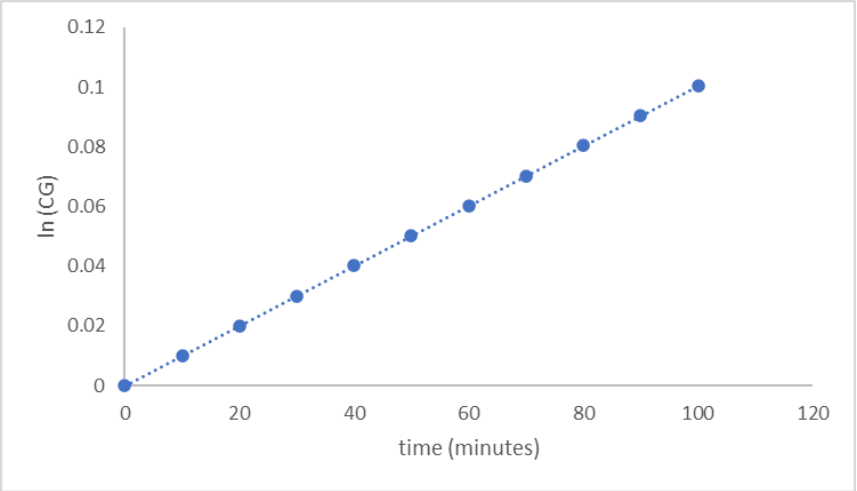
Figure 10. The curve ln C G vs. t of hexogen coating with IPDI.